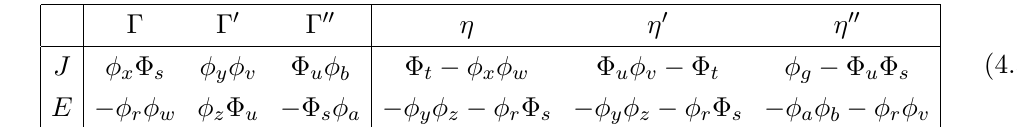
Figure 9 . Sequences of (2,3) and (3,2) moves that encode the (2,4) and (4,2) Pachner moves. work reveals them to